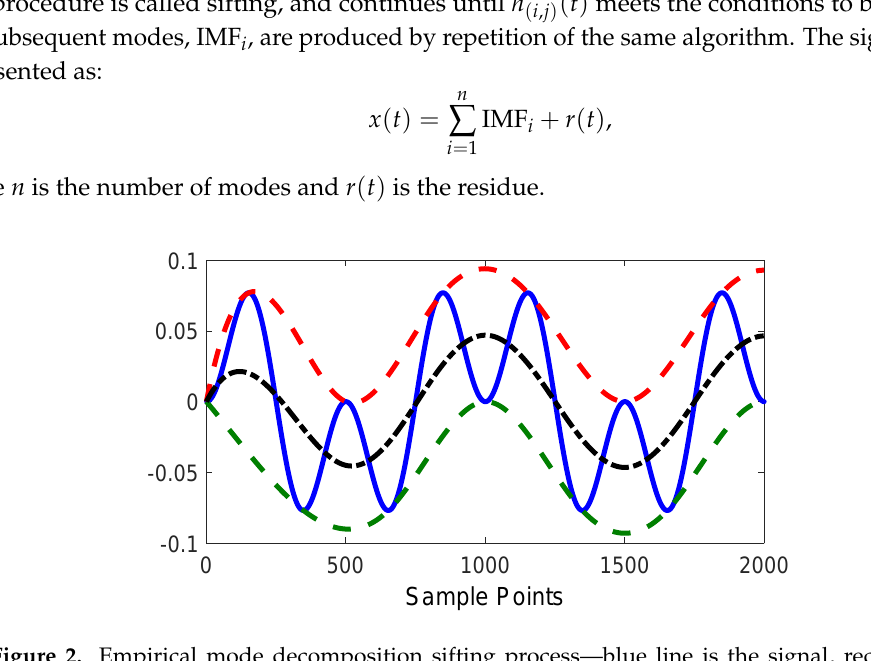
Figure 2. Empirical mode decomposition sifting process—blue line is the signal, red line is the upper envelope, green is lower envelope, and black line is the mean envelope— Y axis represents any arbitrary